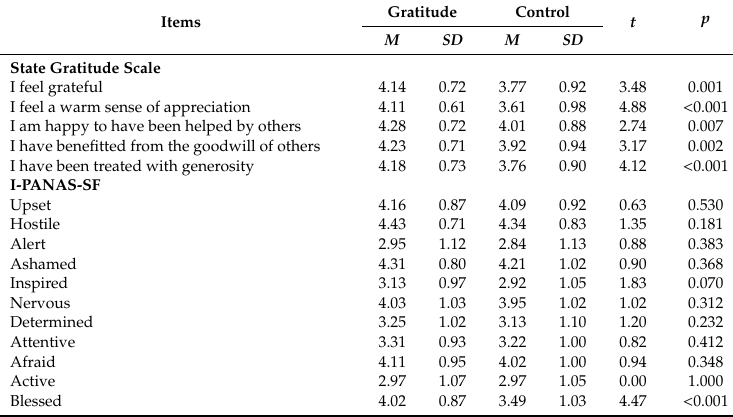
Table 1. Manipulation check in gratitude condition and control condition using State Gratitude Scale and International Positive and Negative A ff ect Schedule Short Form